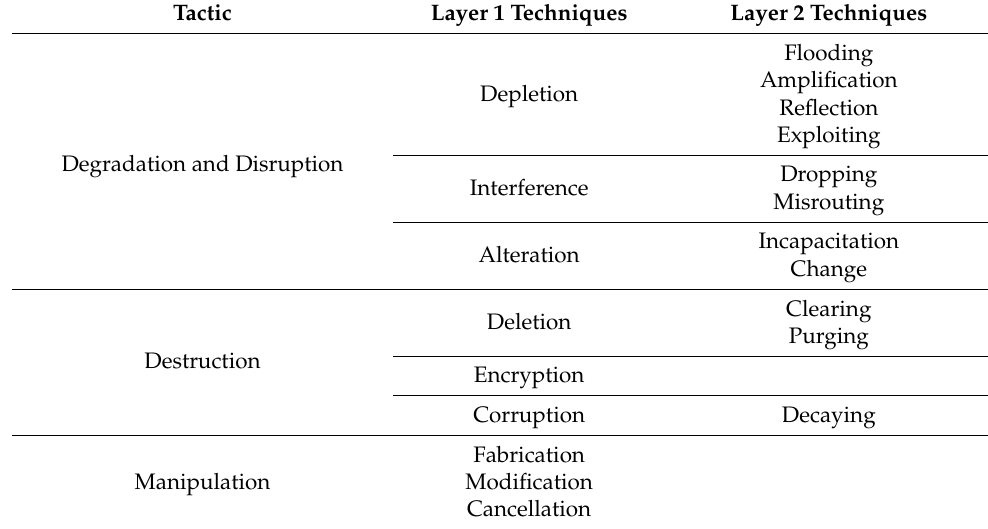
Table 4. CNA techniques structure proposal.